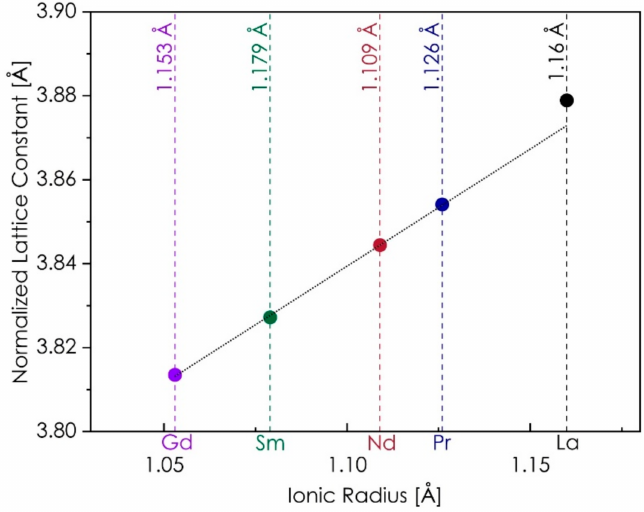
Figure 2. Relation between the quasi-cubic normalized lattice constant a 0 of Ln(Co,Cr,Fe,Mn,Ni)O 3 − δ and ionic radii of the respective Ln ions (for eight-fold coordination [34]). Data for the pellets quenched after sintering at 1000 ◦ C for 20 h. The errors are not marked, as they are within the size of data points. The linear fit for Gd, Sm, Nd, and Pr is extrapolated on the ionic radius of